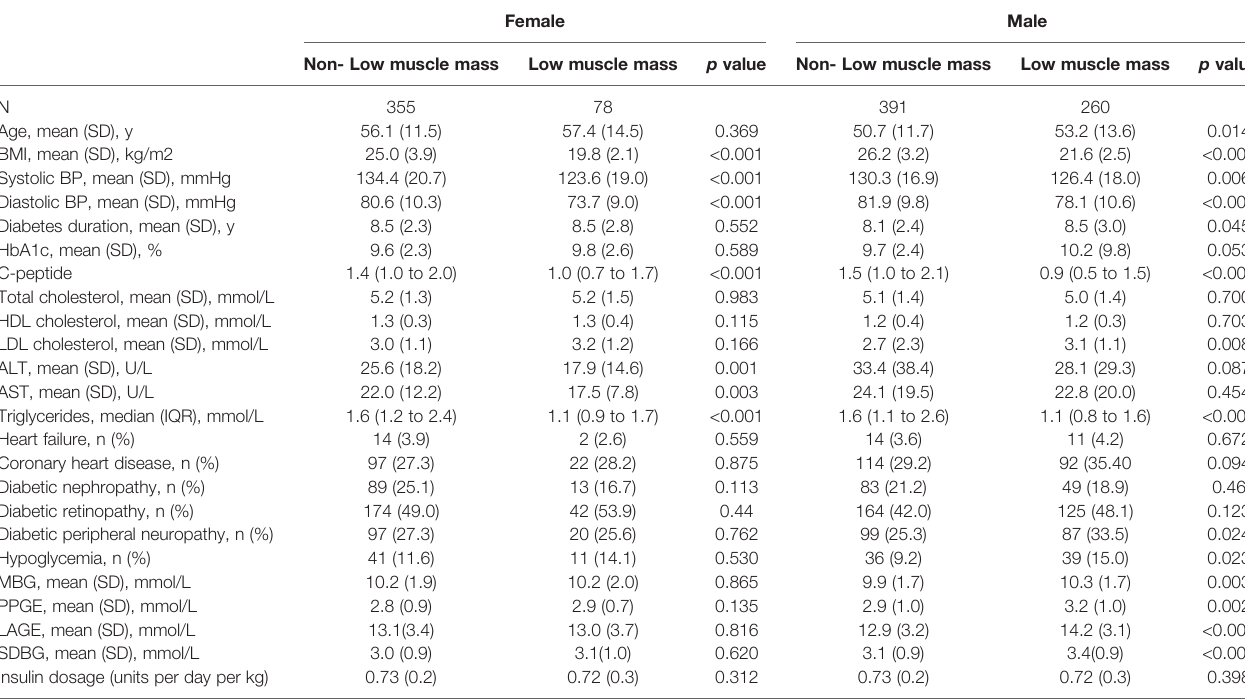
TABLE 1 | Characteristics of the T2DM participants in the Low muscle mass group and non- Low muscle mass group strati fi ed by sex. Female Male Non- Low muscle mass Low muscle mass